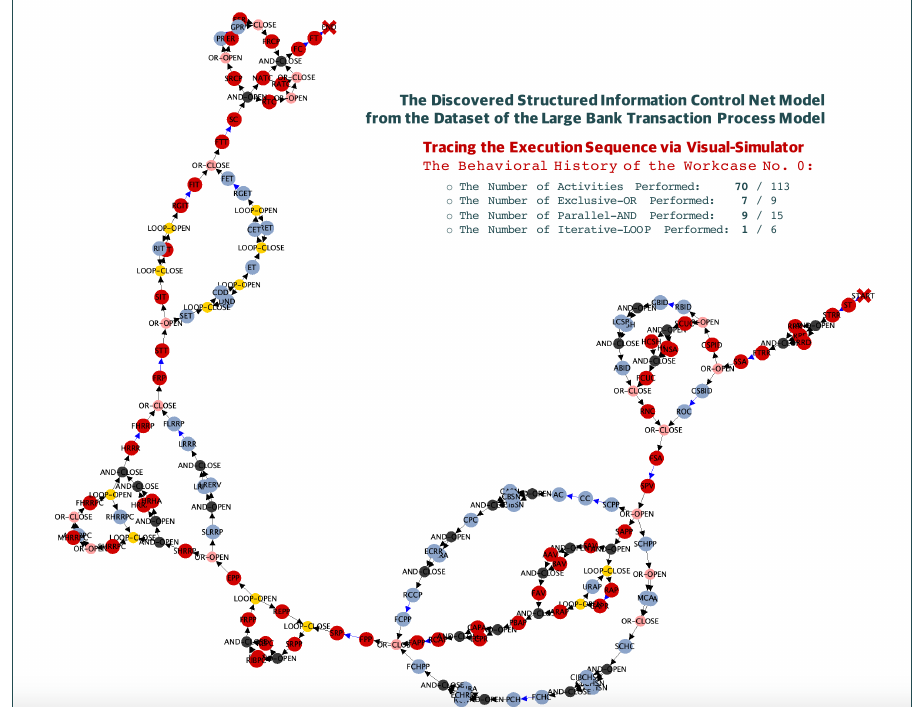
Figure 14. The interactive and visual tracing of behavioral sequences on the rediscovered SICN process model from the Experimental